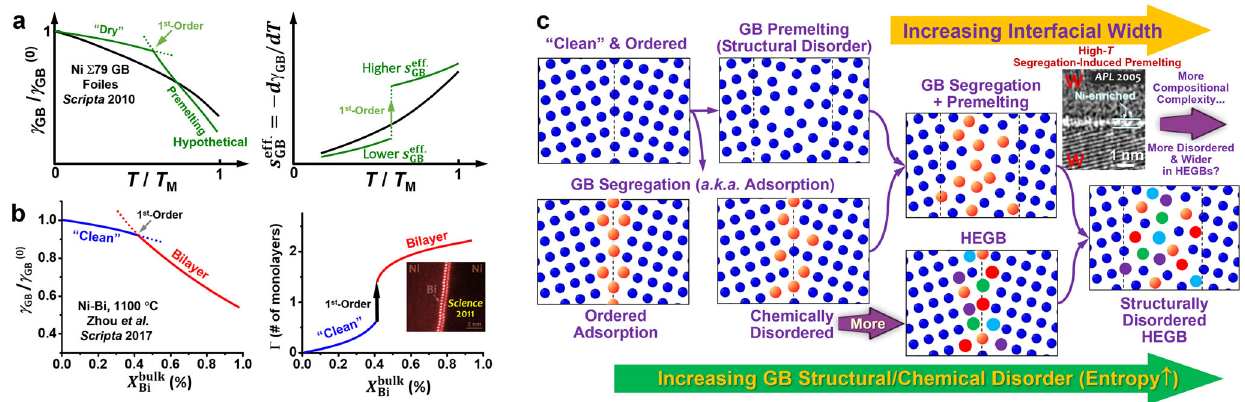
Fig. 1 Grain boundary (GB) disorder, adsorption, and entropy. a Normalized GB energy ( γ GB = γ ð 0 Þ GB ) and d γ GB / dT vs. normalized temperature ( T = T M ) for a Ni Σ 79 GB (replotted after Foiles 21 with permission ©Elsevier 2010) and a hypothetic case with a fi rst-order GB premelting transition. b GB energy ( γ GB ) and GB adsorption ( Γ ) vs. bulk Bi percentage ( X bulk ) for a Bi-doped Ni general GB (replotted after Zhou et al. 23 with permission ©Elsevier 2017), where the Bi inset is a scanning transmission electron microscopy image of Bi bilayer adsorption (reprinted after Luo et al. 29 with permission ©AAAS 2011). c Schematic illustration of different GB structures with increasing structural and/or chemical disorder and entropy. Insets are high-resolution transmission electron microscopy images showing coupled GB premelting and segregation in Ni-doped W (reprinted after Luo et al. 30 with permission ©AIP